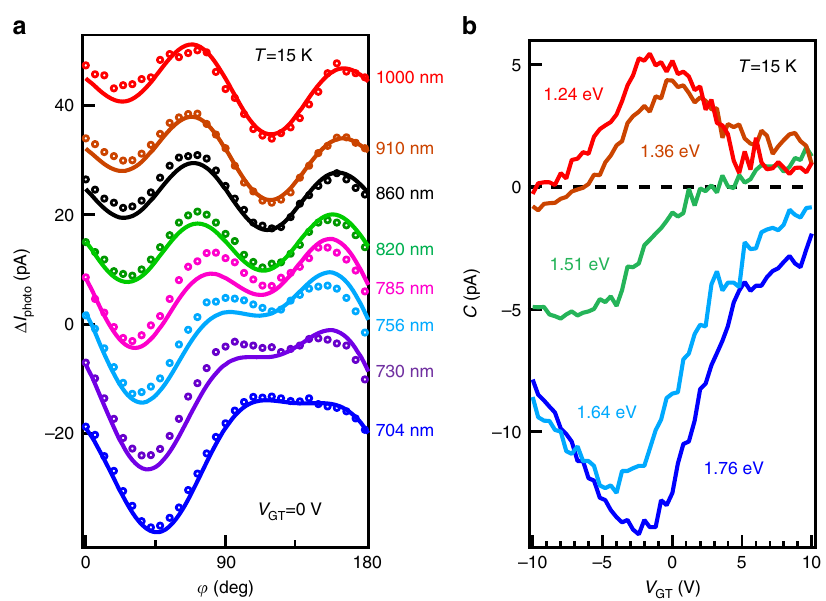
Fig. 3 Photocurrent excited by photons of different wavelength, ranging from 704 nm (1.76 eV) to 1000 nm (1.24eV). a The polarization-dependent photocurrent at each wavelength, with solid lines showing fi ts to Eq. (1). The curves are vertically offset for clarity. b The gate voltage dependence of the HDPC at fi ve different photon energies ranging from 1.24 to 1.76 eV. At 1.24 eV, the HDPC is positive and reaches a peak at the voltage corresponding to the Dirac point in the R xx measurement. When we increase the photon energy, the HDPC starts to become negative and fi nally becomes a valley at 1.76 eV. The valley bottom is also around the Dirac